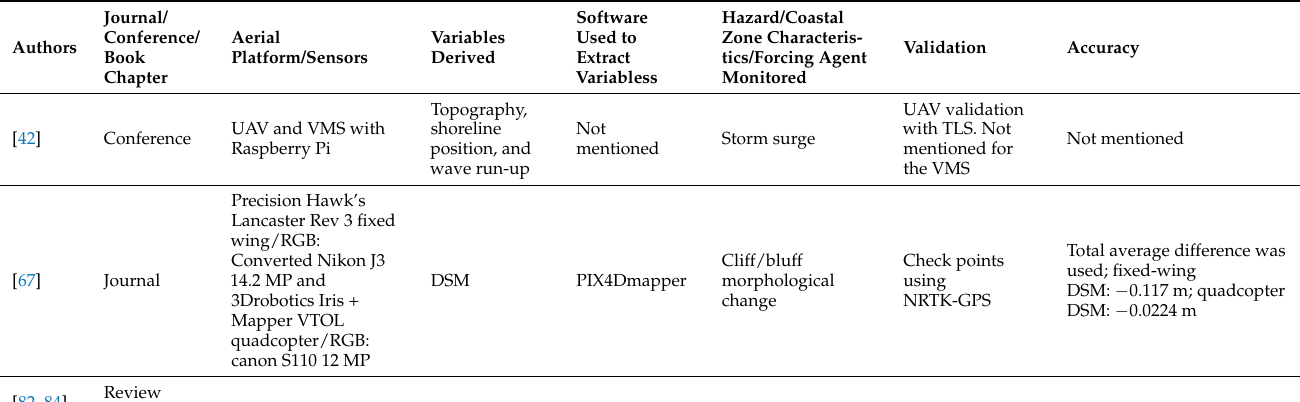
Table 4. Summary of papers on aerial photogrammetry that includes type of paper, aerial plat- form/sensors used, parameters derived, software used to extract parameters, hazards/forcing agents monitored, validation, and